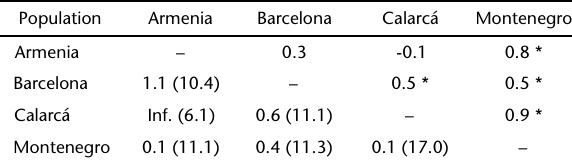
Table V. Genetic distances (Fst values, above the diagonal) and effective number of migrants (Nm, below the diagonal) of four natural Aedes aegypti populations from Quindío,